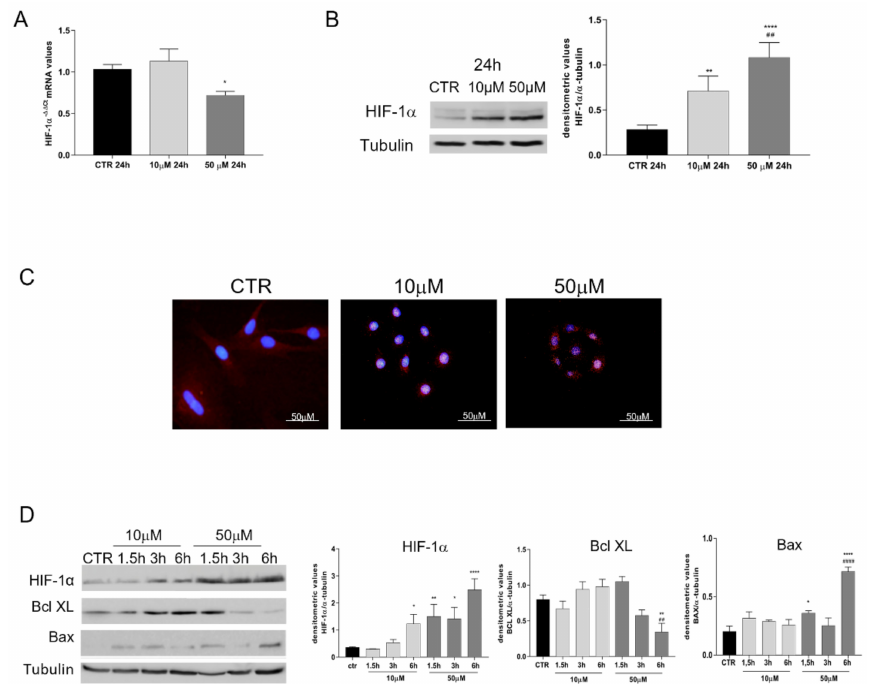
Figure 3. Evaluation of HIF-1 α activation and early apoptotic markers in CTR and 10 and 50 µ M CoCl 2 -treated oAECs. ( A ) RT-PCR analysis of HIF-1 α at 24 h of CoCl 2 incubation. Relative quantifica- tion of mRNA gene expression was calculated using the ∆∆ Ct method and presented as fold change to CTR (calibrator). ( B ) Representative Western Blot image of HIF-1 α and relative densitometric values normalized on Tubulin expression. ( C ) Representative immunofluorescence images of HIF-1 α localization (red fluorescence) in CTR and CoCl 2 -treated oAECs after 24 h of culture. Nuclei are counterstained with DAPI (blue fluorescence), Scale bar: 10 µ m. ( D ) Time course of HIF-1 α , Bcl XL, Bax proteins expression and relative densitometric values normalized on Tubulin expression. Data were expressed as mean ± SEM values of samples, each performed in triplicate, obtained at least from three different animals. Values statistically different for * p < 0.05, ** p < 0.001, **** p < 0.0001